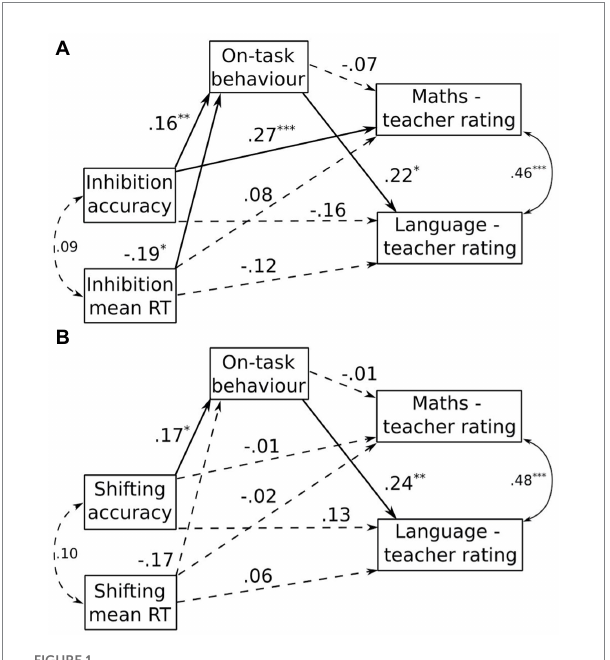
FIGURE 1 Path models of the indirect effects of (A) inhibition and (B) shifting on academic achievement. Note: All path coefficients are standardised. Significance set at p < 0.05. * p < 0.05, ** p < 0.01, *** p < 0.001. Significant paths are drawn in solid